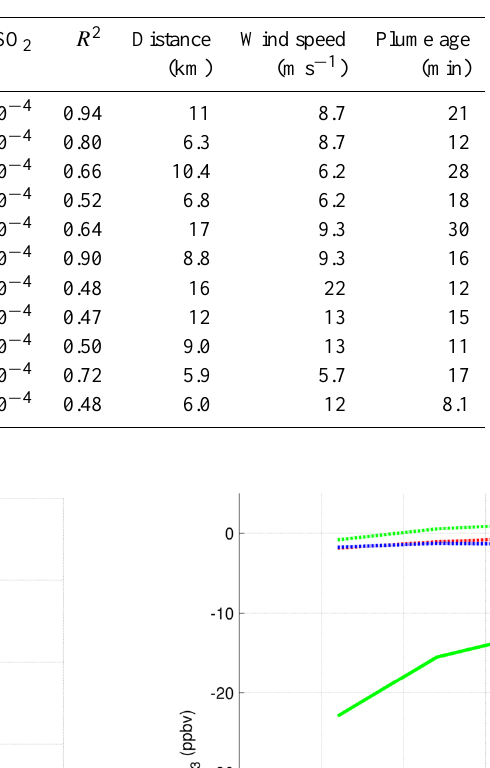
Table 5. Spectroscopic measurements of the Mount Etna plume. These data are also plotted on Fig. 11. R 2 refers to the correlation of BrO and SO 2 within the measurements.